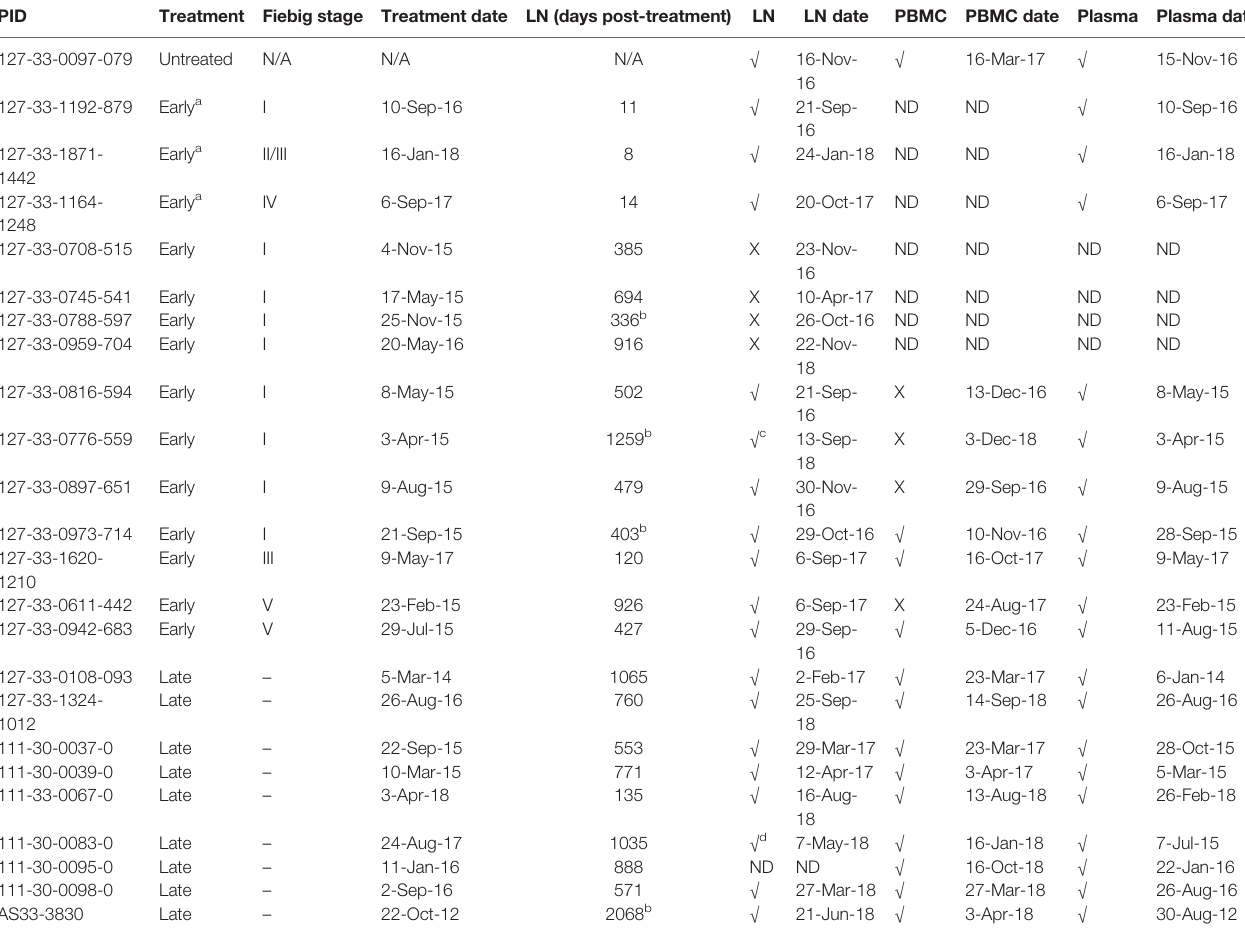
TABLE 1 | HIV-1 gag ampli fi cation from lymph nodes (LN), peripheral blood mononuclear cells (PBMC) and plasma. PID Treatment Fiebig stage Treatment date LN (days post-treatment)